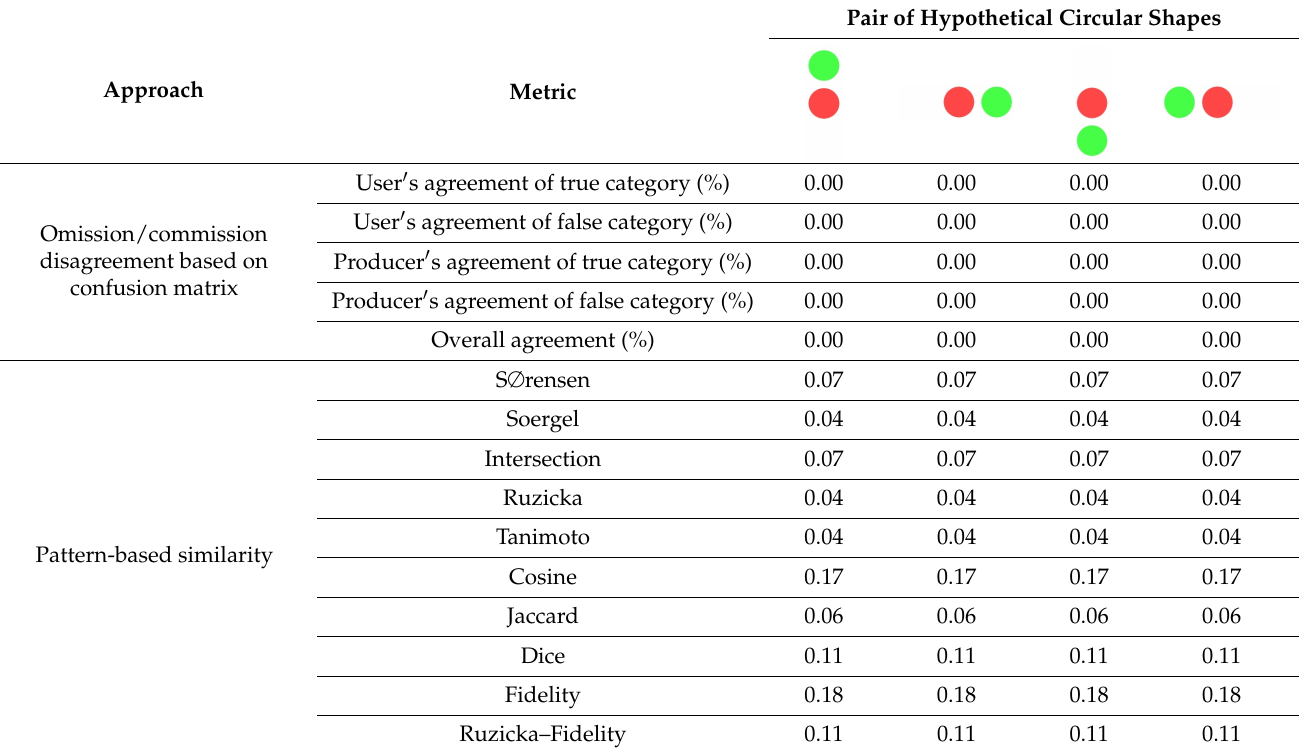
Table A4. Comparison between omission/commission disagreement approach and pattern-similarity based approach to measure pairs of a hypothetical circular shape and their displacements in cardinal directions that are